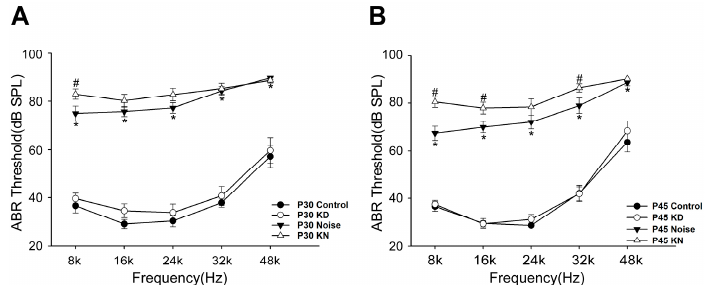
Figure 2. Hearing thresholds shift after Cx26 reduction and noise exposure. Auditory thresholds were measured in control, KD, noise and KN group at P30 ( A ) and P45 ( B ). * Significantly different from the control group ( p < 0.01); # Significantly different from the noise group ( p < 0.01). Plot legends for different groups are given in the panel.